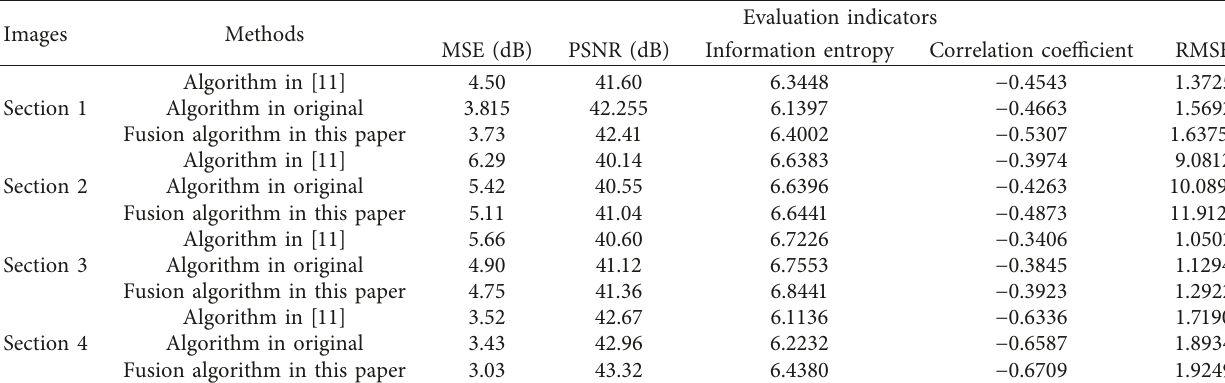
Figure 5: Edge detection of images of colon pathological sections. Table 2: Objective evaluation